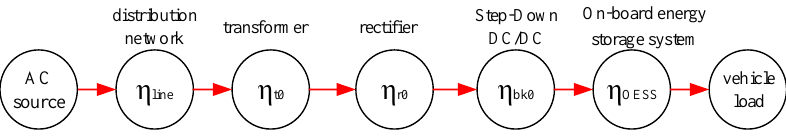
Figure 3. Efficiency flow block diagram of the direct charging system.